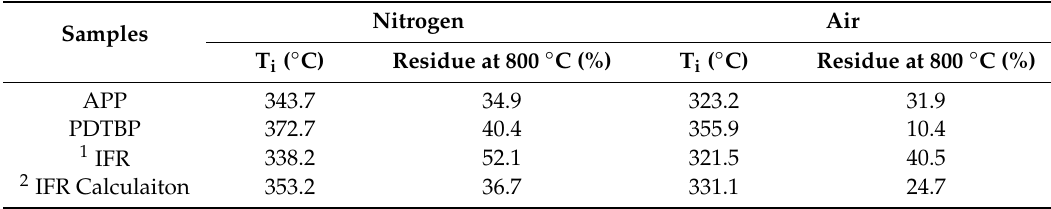
Figure 7. Thermogravimatric analysis (TGA) curves of ammonium polyphosphate (APP), PDTBP, IFR, and IFR calculation in nitrogen ( a ) and air ( b ) atmosphere. Table 4. TGA data of APP, PDTBP, IFR, and IFR calculation in nitrogen and air atmosphere.